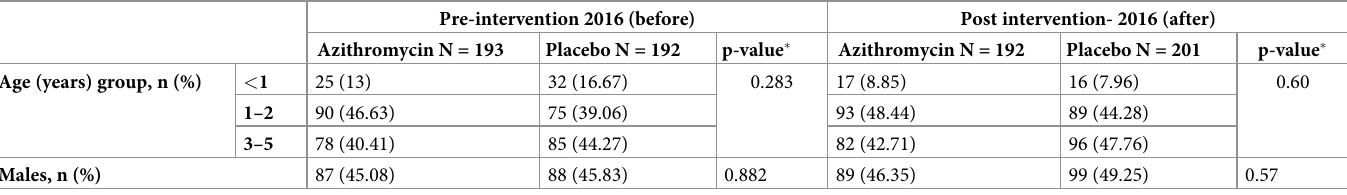
Table 1. Socio-demographic characteristics of the study population. Pre-intervention 2016 (before) Post intervention- 2016